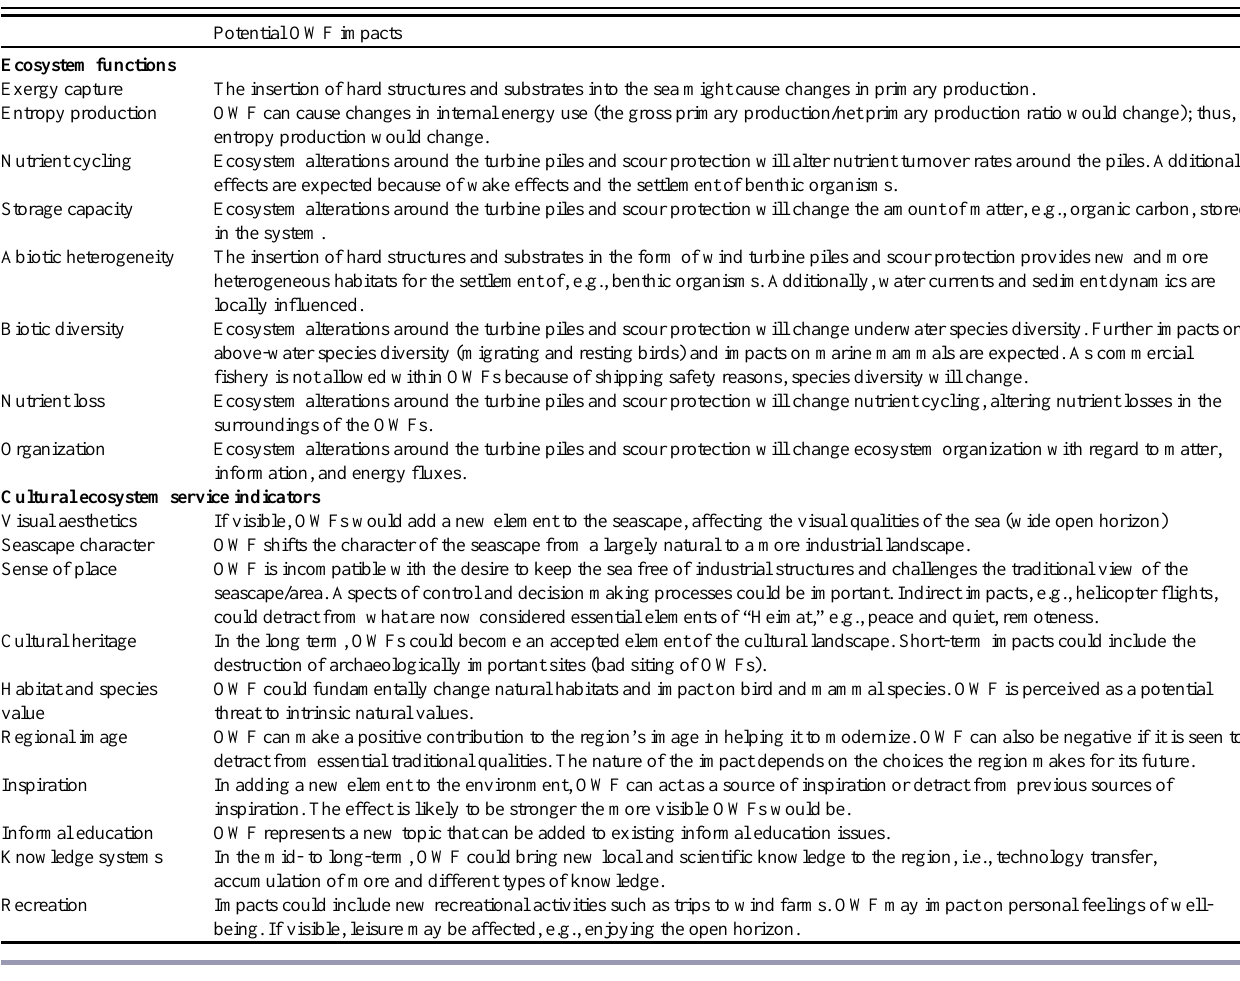
Table 1 . Indicators used for the description of potential offshore wind farming (OWF)-related ecosystem development and impacts on cultural ecosystem services (adapted from Busch et al.